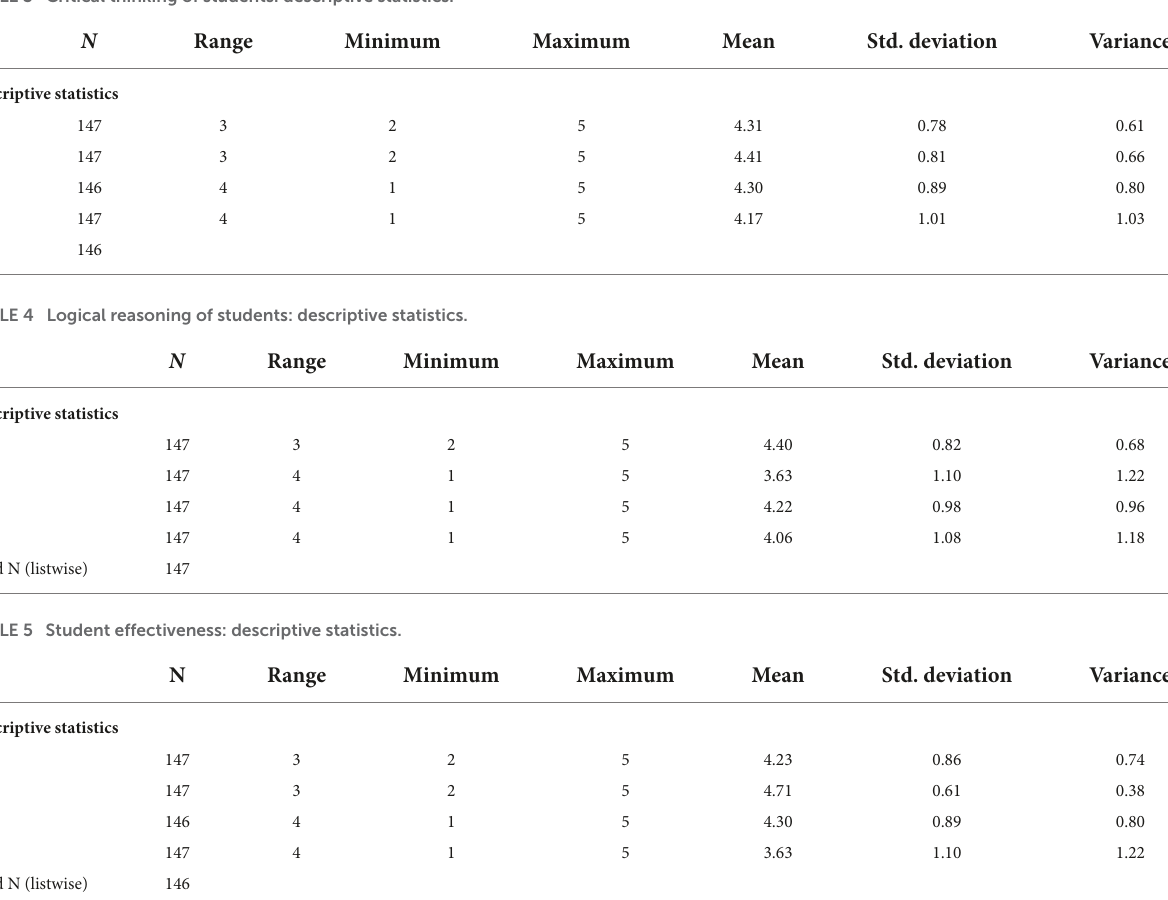
TABLE 3 Critical thinking of students: descriptive statistics.